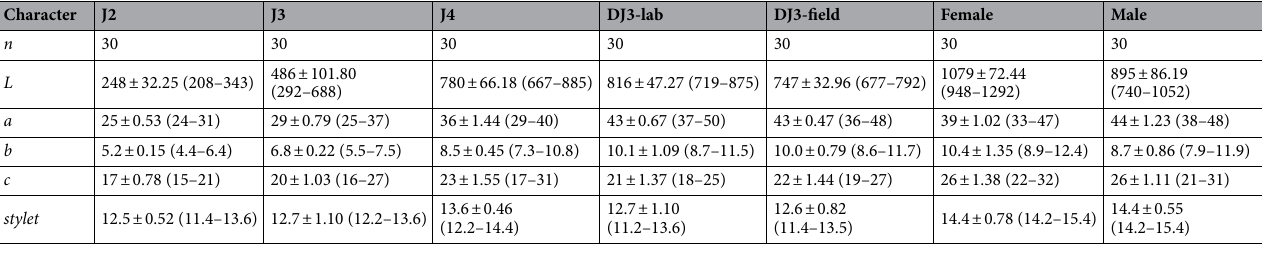
Table 1. Morphometrics of different stages of PWNs. All measurements are in μ m and in the form: mean ± s.d. with (range).